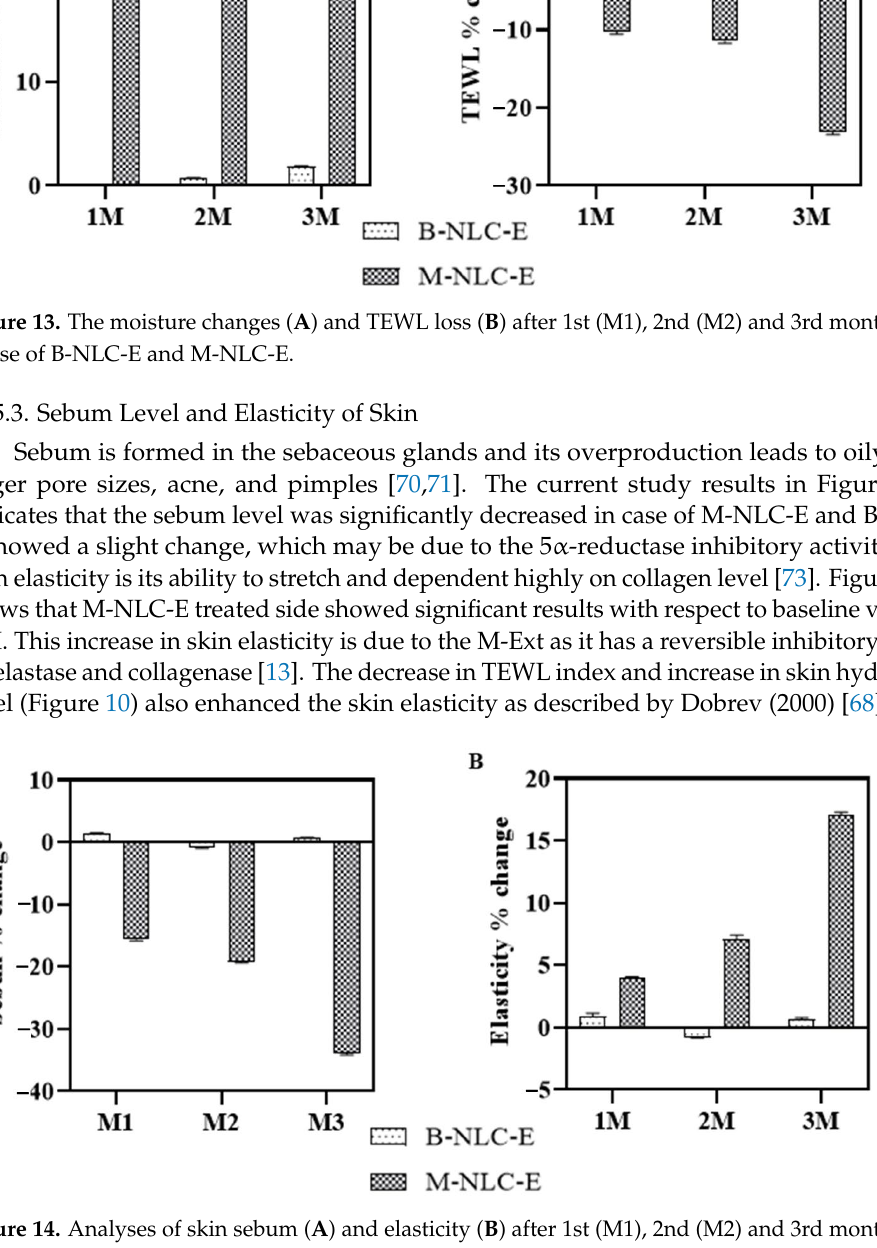
Figure 12. Erythema ( A ) and Melanin contents ( B ) change after 1st (M1), 2nd (M2) and 3rd month (M3) of use of B-NLC-E and M-NLC-E.